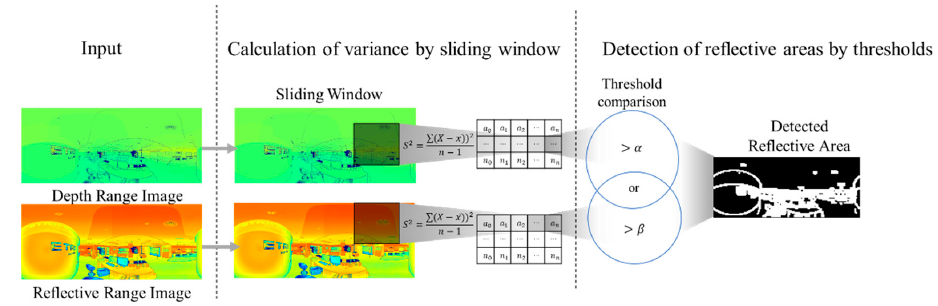
Figure 8. Overview of the variance-based sliding window approach.